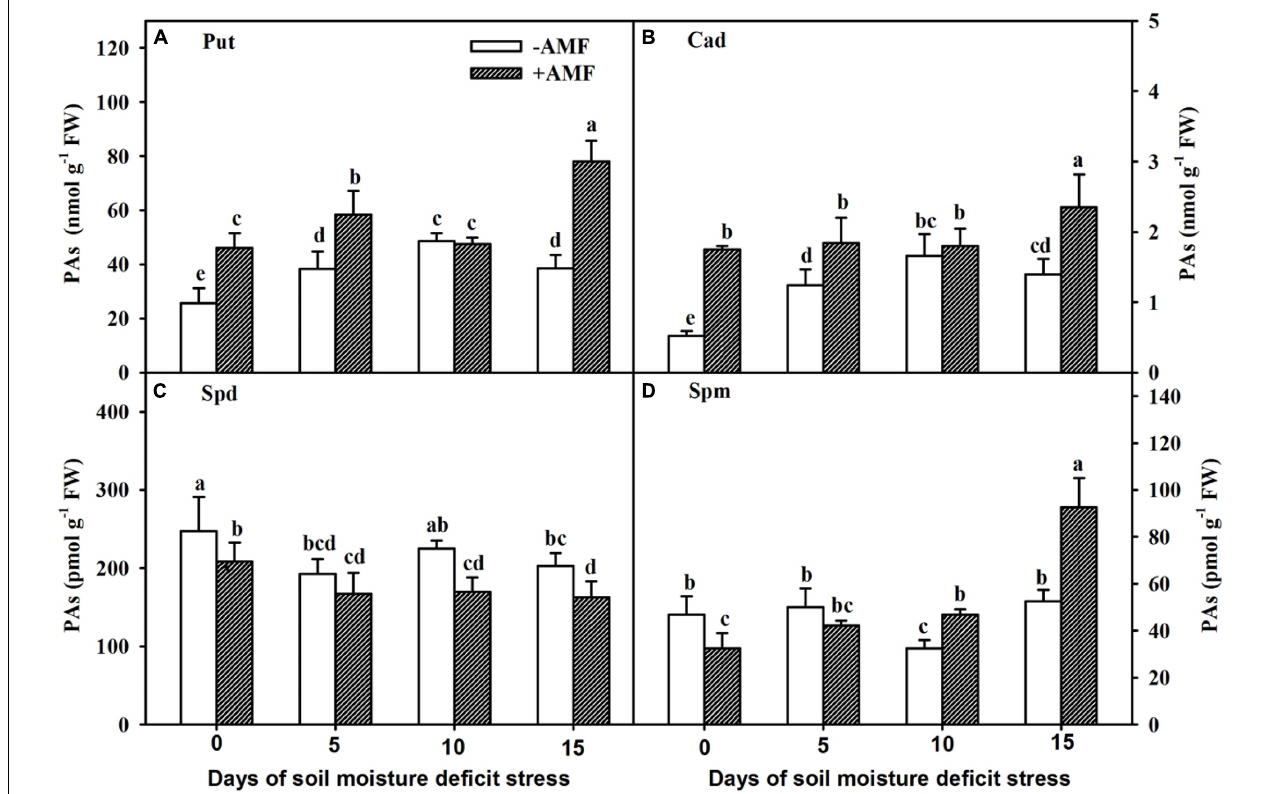
FIGURE 5 | Concentrations of root putrescine (Put) (A) , cadaverine (Cad) (B) , spermidine (Spd) (C) , and spermine (Spm) (D) of trifoliate orange seedlings inoculated with and without Funneliformis mosseae during exposure to soil moisture deficit stress (SMDS) of 0-15 days. Data (mean ± SD, n = 4) followed by different letters above the bars indicate significant ( P < 0.05)